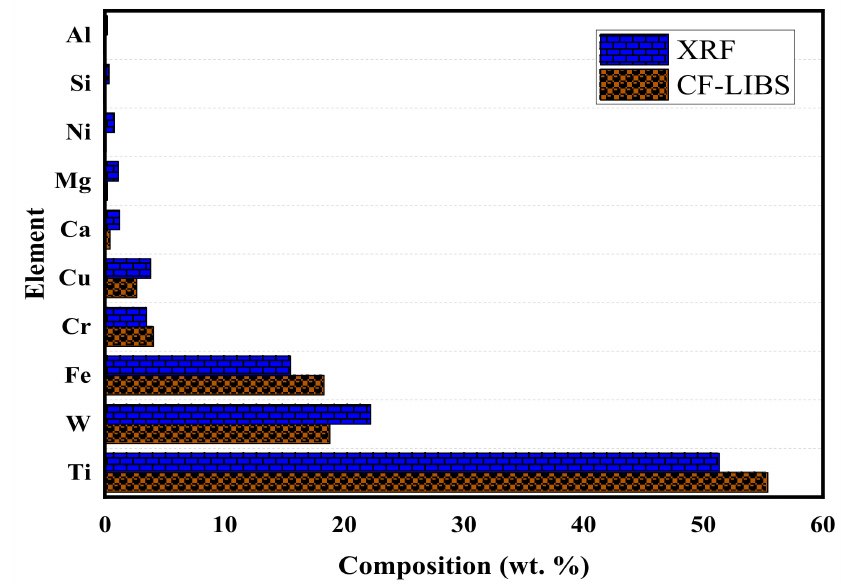
Figure 5. Elemental composition of astrophyllite as measured by CF-LIBS and XRF. Table 5. Relative error of each element quantified by LIBS and XRF.